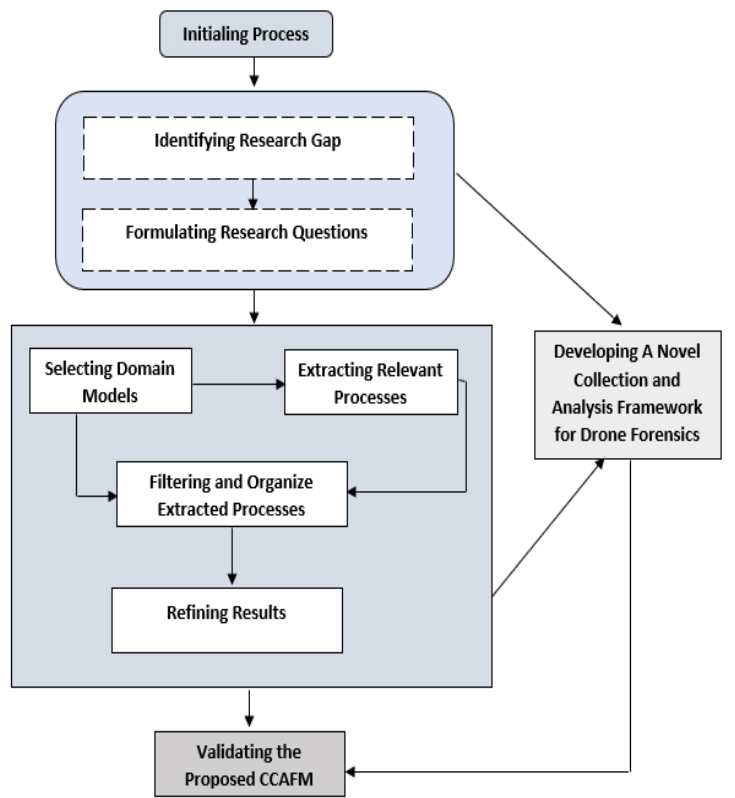
Figure 3. Framework for the model development process.